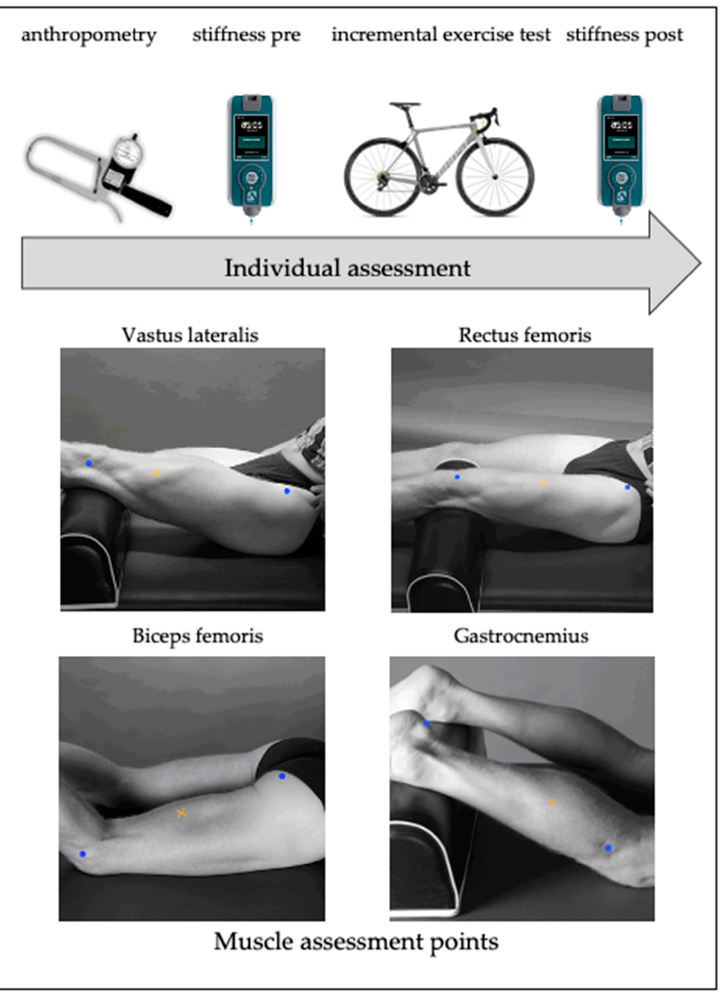
Figure 1. Experimental approach timeline and muscle assessment points. Blue marks: proximal and distal measurement area. Yellow mark: Myoton assessment point.